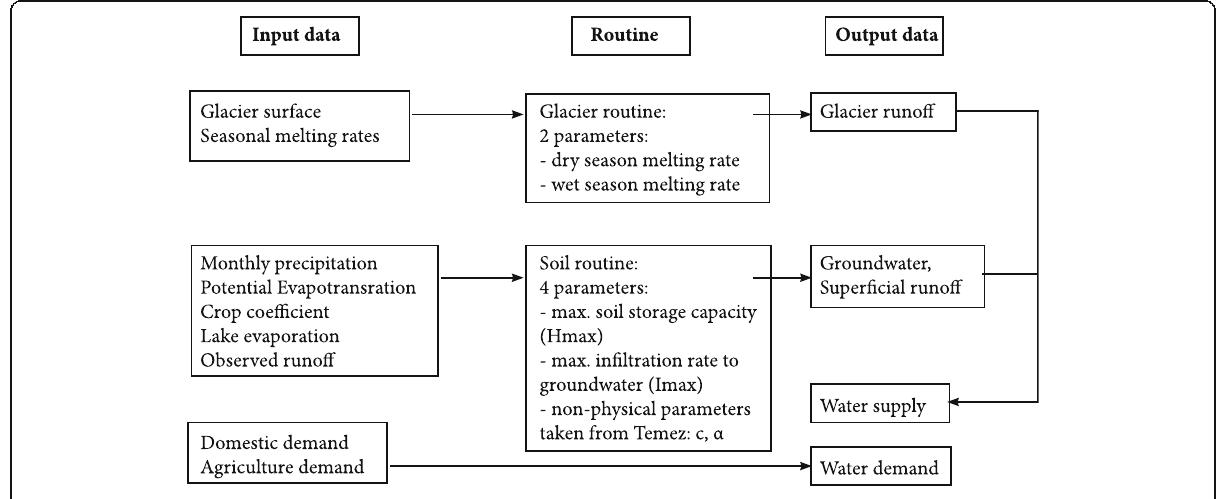
Fig. 2 Scheme of the Temez modified hydrological